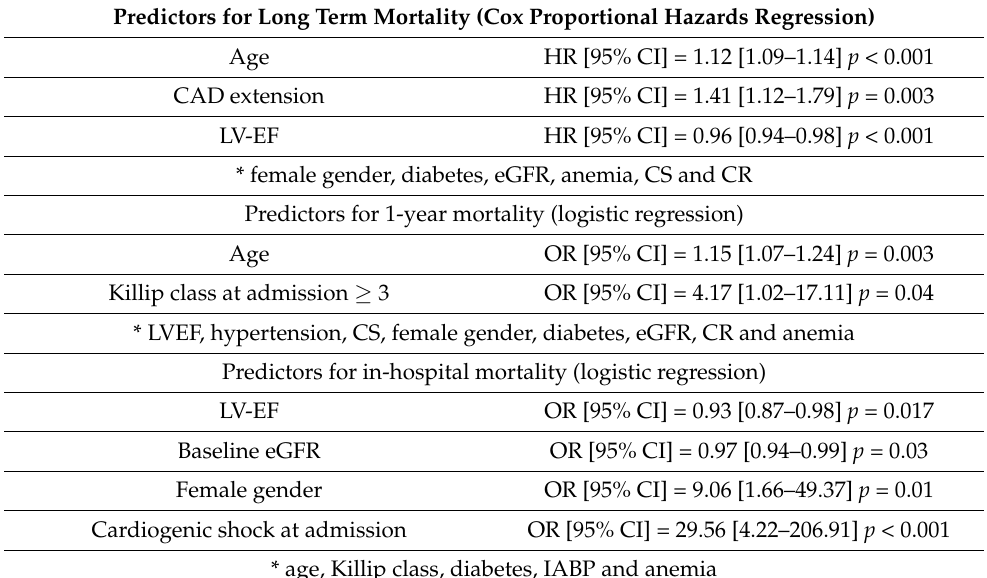
Table 4. Main independent predictors for short- and long-term mortality in patients with